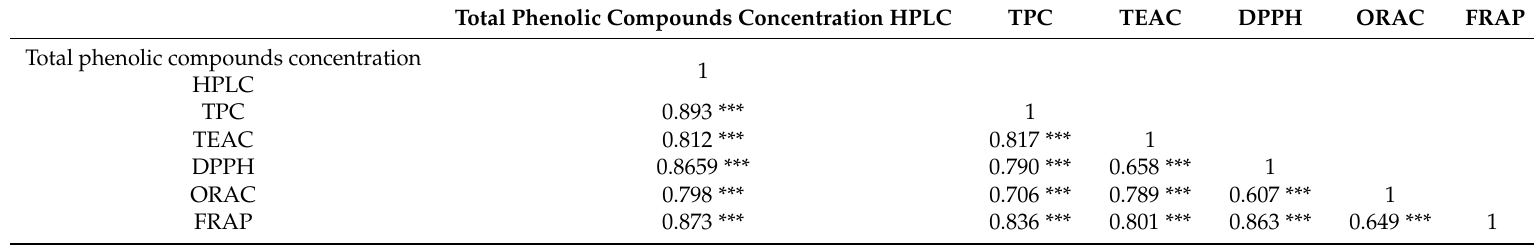
Table 3. Pearson correlation coefficient among total phenolic compounds concentration determined by HPLC method, TPC, TEAC, DPPH, ORAC, and FRAP